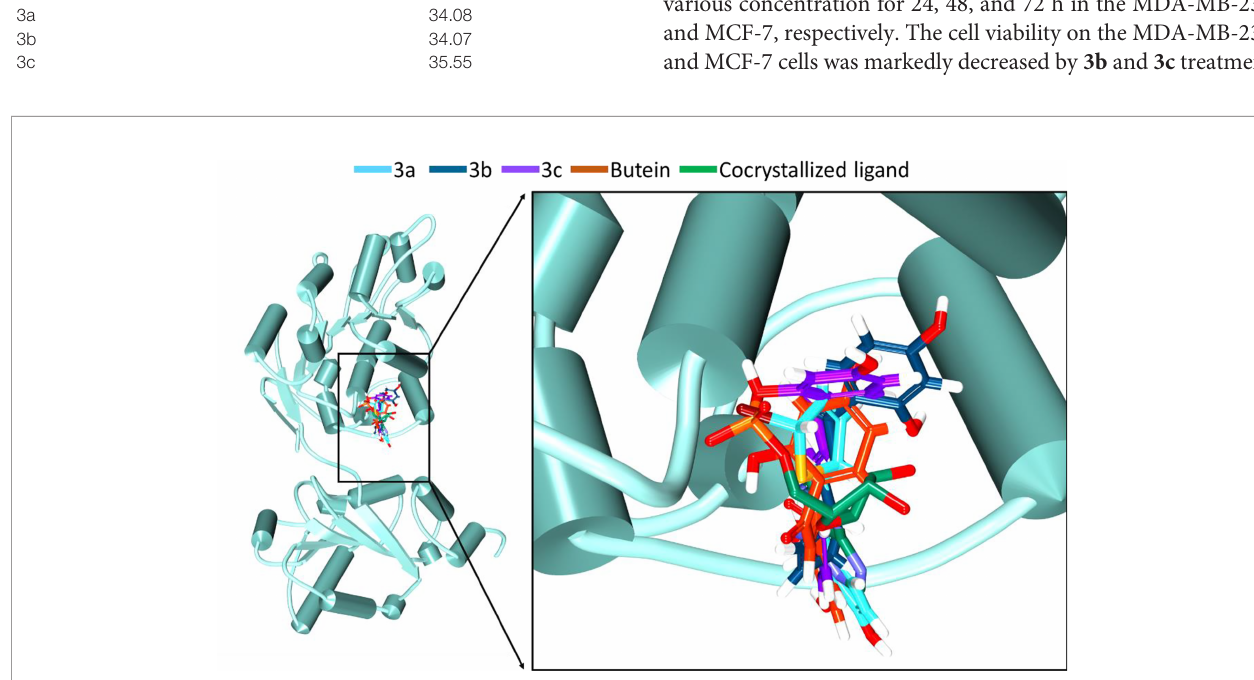
FIGURE 2 | Accommodation of the synthesized compounds at the ATP binding pocket of DDX3 in comparison with butein and the cocrystallized ligand. The new compounds have displayed a similar binding mode as that of the cocrystallized